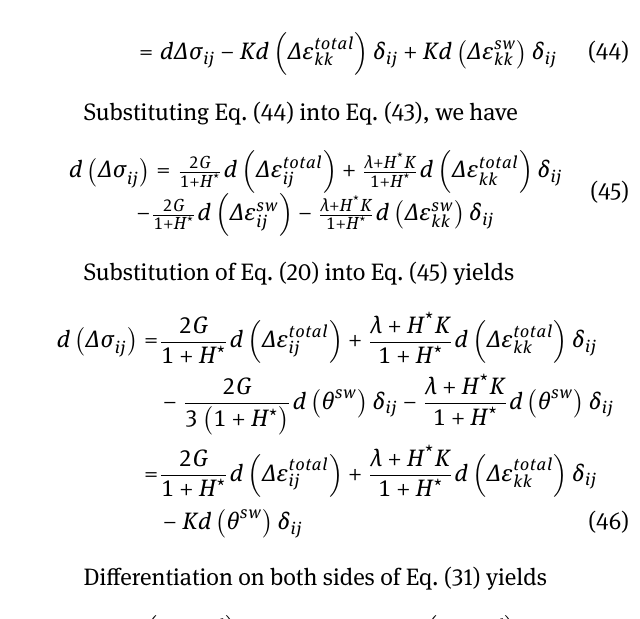
Figure 1: Flow chart of stress-update